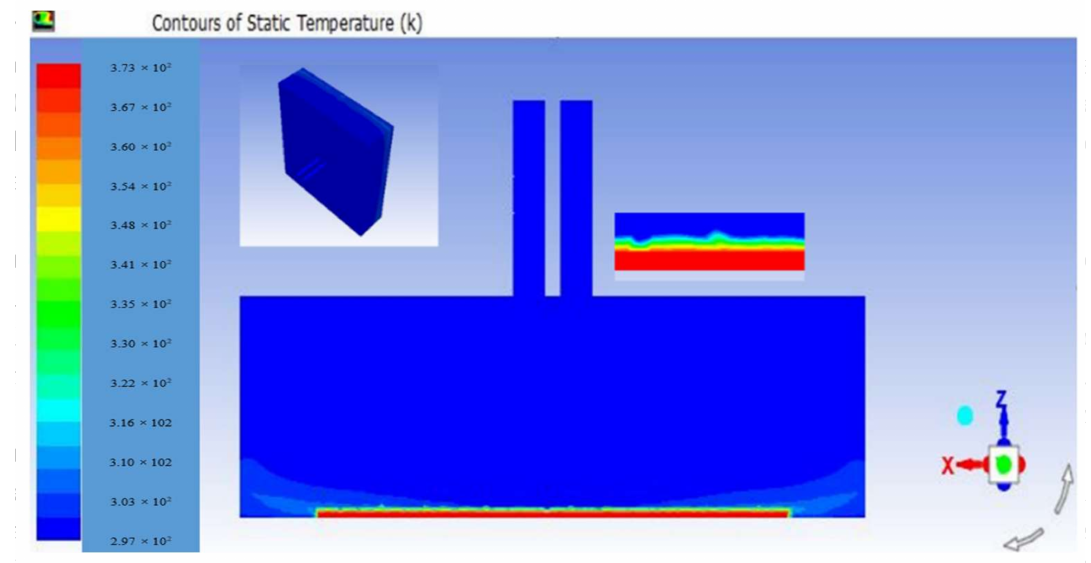
Figure 19. Static temperature contours of the twin jets impingement on the aluminum hot plate at S = 1 cm and H = 11 cm.